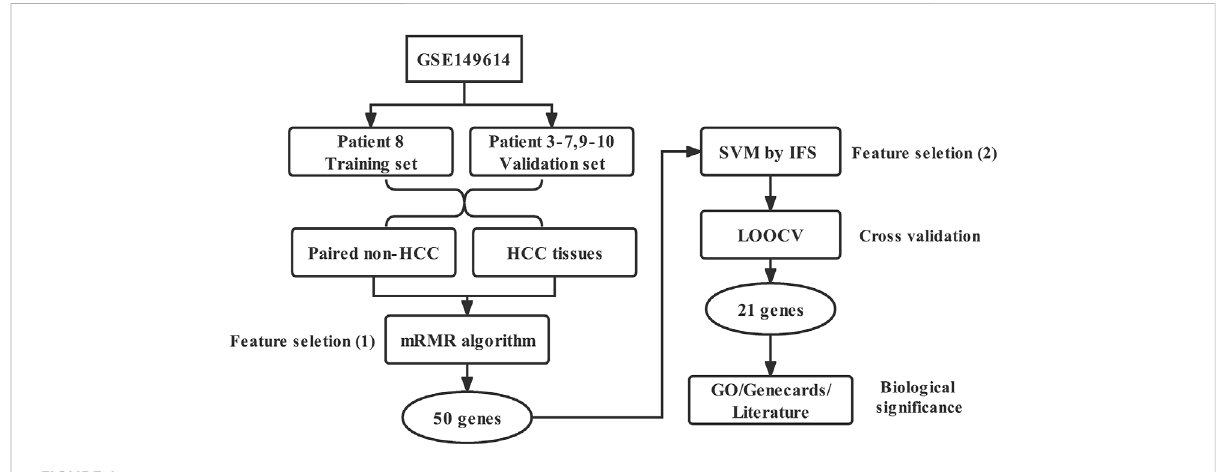
FIGURE 1 Work fl ow diagram of this